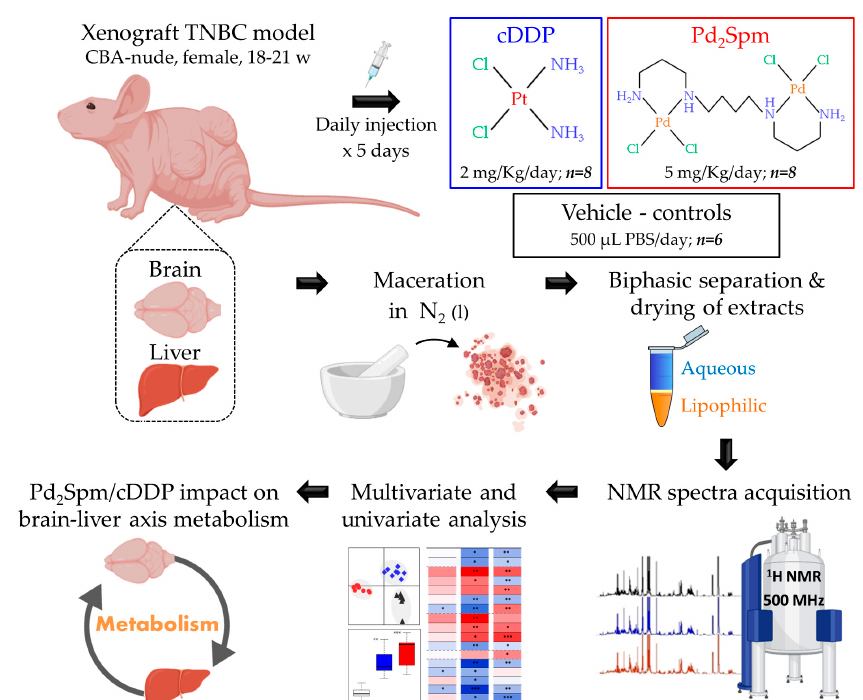
Figure A1. Experimental design workflow illustrating the animals’ exposure to the metal-drugs, cDDP (2 mg/kg/day) or Pd 2 Spm (5 mg/kg/day), and vehicle solution (phosphate-buffered saline, PBS), followed by brain and liver excision and extracts preparation using a mechanical maceration in liquid nitrogen (N 2 ) and a biphasic separation with MeOH/H 2 O/CDCl 3 , and, ultimately, the NMR spectra acquisition and chemometric analysis. Figure created with BioRender.com [90].